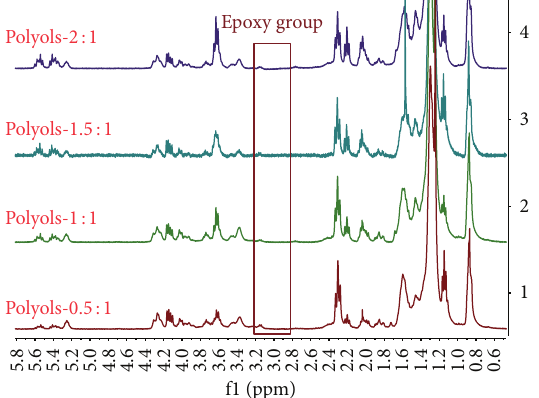
Figure 13: Rheological behaviors of polyols with different ratios between COD and